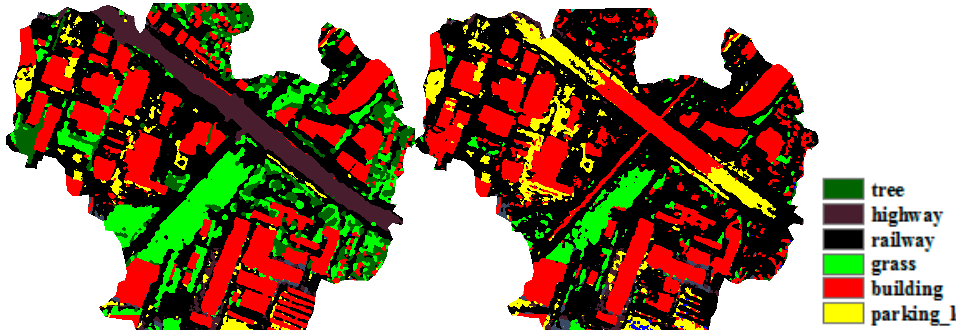
Figure 8. Classified maps in the shadow area obtained from object-based classification (left) and the traditional pixel-based support vector machine (SVM) classifier (right).